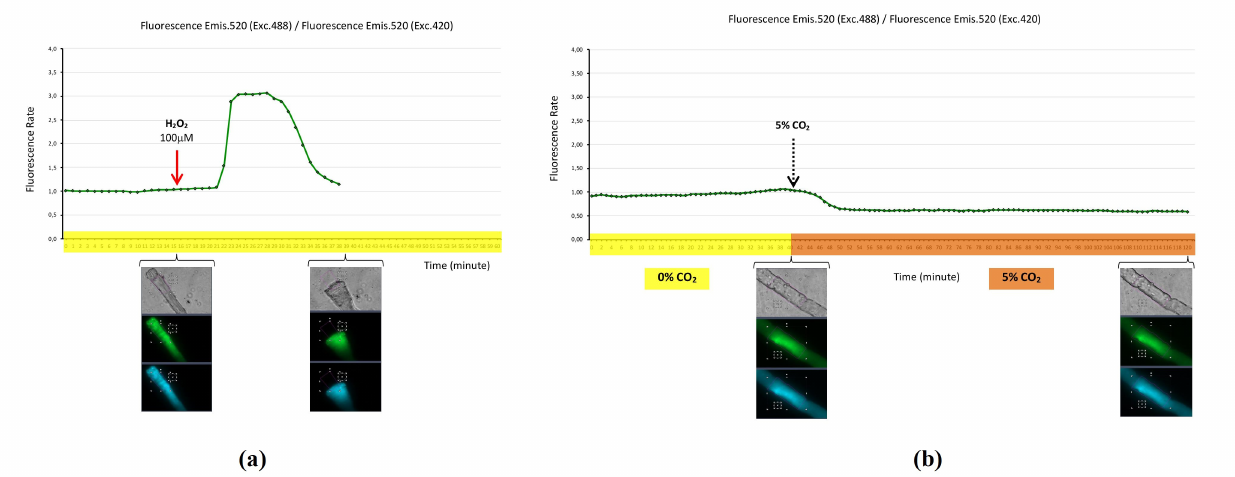
Figure 2. Hydrogen peroxide biosensor HyPer-mito expressed in the mitochondria of single skeletal muscle fibers. ( a ) Mito- chondrial fluorescence monitoring during a time course of 60 min, with fluorescence image registration every minute. Fibers were maintained at 37 ◦ C in a 0% CO 2 atmosphere (timeline highlighted in yellow). Hydrogen peroxide (100 µ M) was added to fiber medium at the 15 min timepoint. Fluorescence values are expressed as the fluorescence rate: Fluorescence emission at 520 nm when excited at 488 nm divided by fluorescence emission at 520 nm when excited at 420 nm. At timepoints 15 and 39 min, are two sets with three fiber images: Transmission (grey), green fluorescence (emis. 520, exc. 488), and blue fluorescence (emis. 520, exc. 420). Fibers were affected by toxicity at the 39 min timepoint and the values of fluorescence were discarded; ( b ) mitochondrial fluorescence monitoring during a time course of 120 min, with fluorescence image registration every minute. Fibers were maintained at 37 ◦ C in a 0% CO 2 atmosphere (timeline highlighted in yellow) during the first 40 min, following by 37 ◦ C in a 5% CO 2 atmosphere (timeline highlighted in orange) for 80 min. Sets of fiber images: Transmission (grey), green fluorescence (emis. 520, exc. 488), and blue fluorescence (emis. 520, exc. 420) at timepoints 40 and 120 min. Fluorescence values are expressed as the fluorescence rate: Fluorescence emission at 520 nm when excited at 488 nm divided by fluorescence emission at 520 nm when excited at 420 nm. (Supplementary enlarged